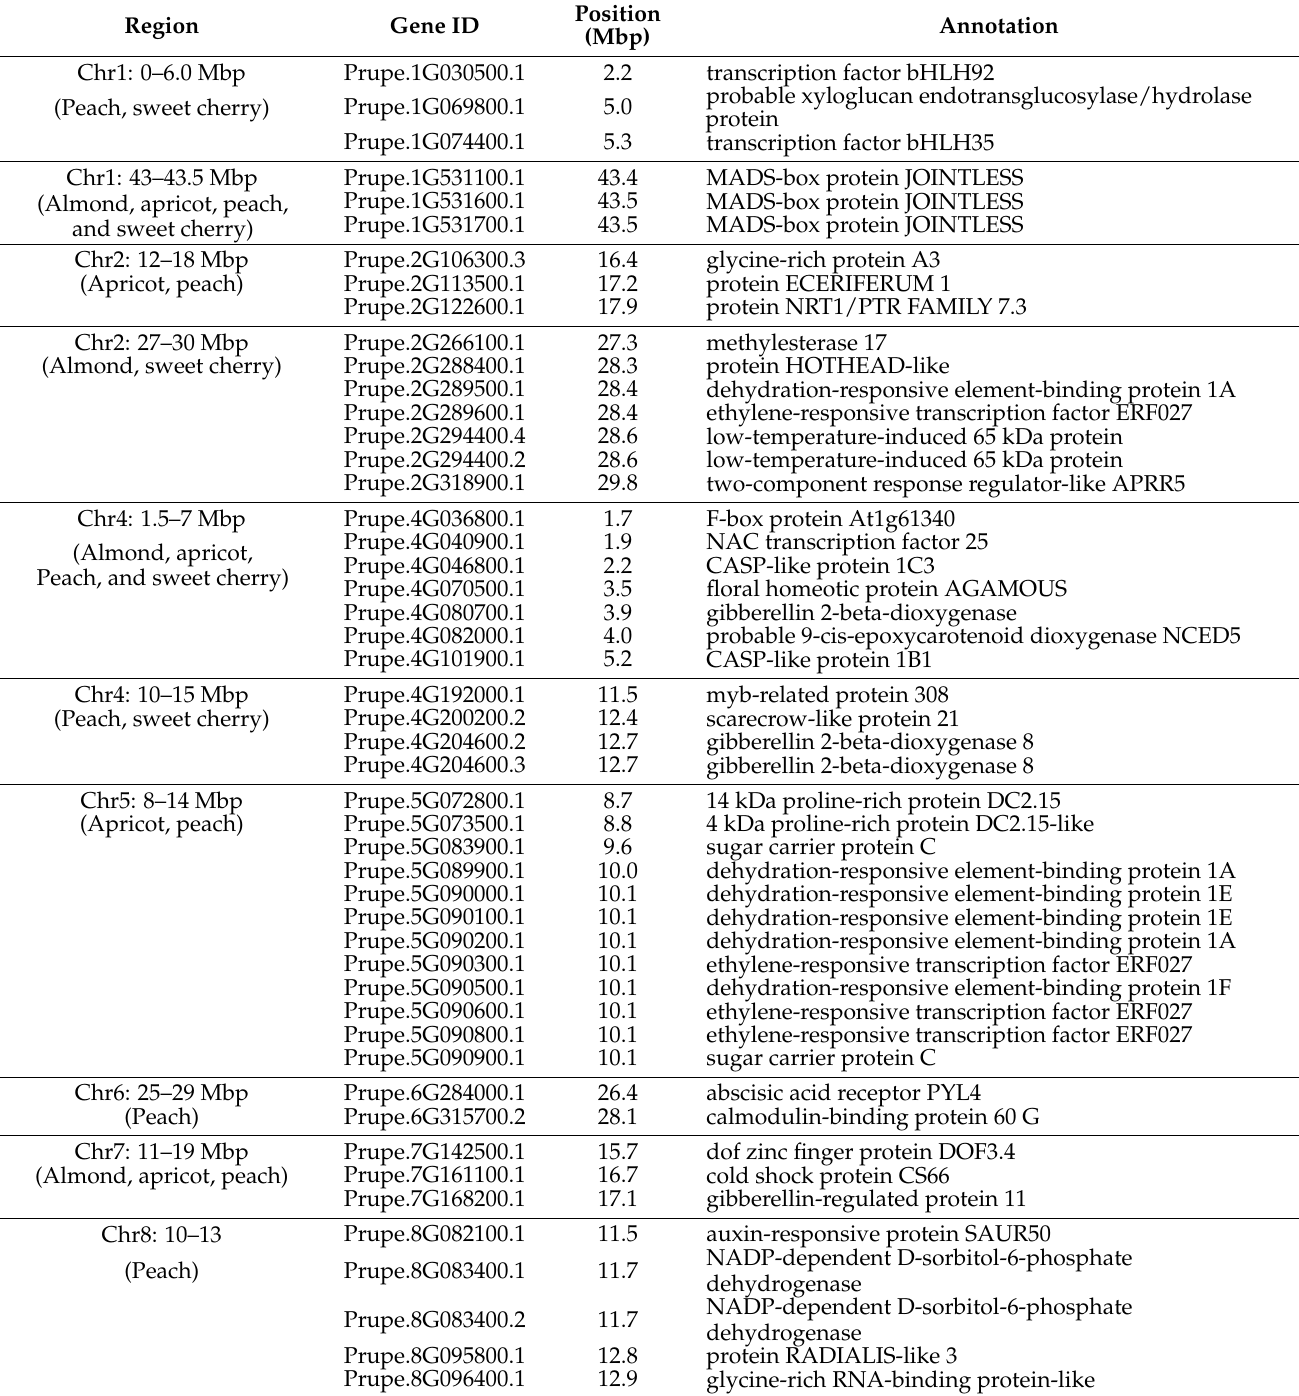
Table 2. Genes differentially expressed in Prunus cultivars with annotations related to dormancy control within main bloom time, chilling and, heat requirement QTLs previously found in almond, apricot, peach, and sweet cherry. Gene ID, gene position, and QTL region based on peach genome